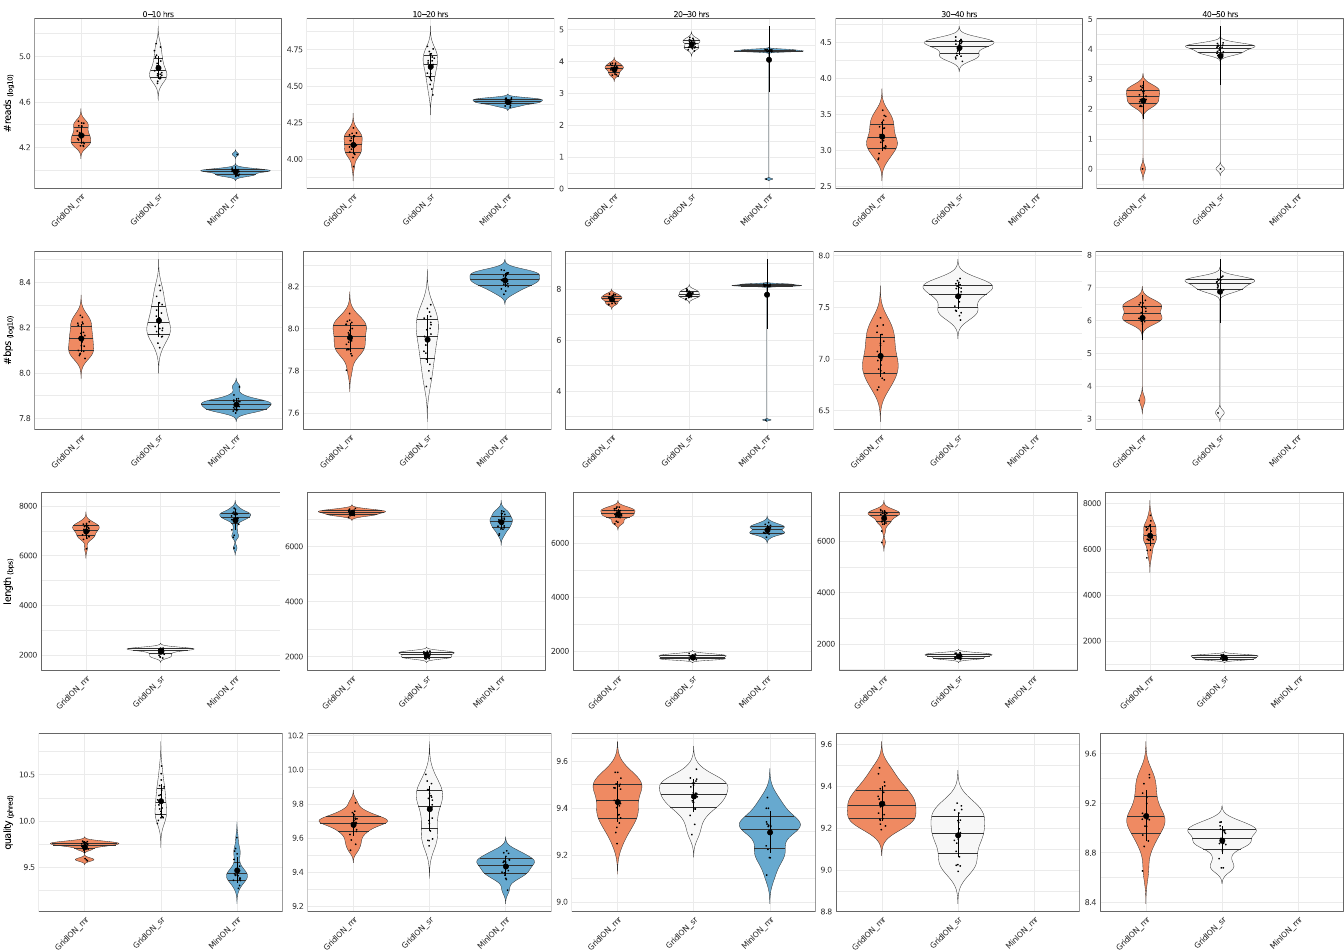
Fig 5. Violin plots for comparison between experiments. From top to bottom, the plots show the comparison 3 ONT experiments (first 2 are GridION X5 experiments, producing multi-read and single-read . fast5 files respectively and last is a MinION experiment producing multi-read . fast5 files) in terms of reads number, base pairs number, reads mean length and reads mean quality. Comparison is done every 10 hours of experiment using time bins of 30 minutes.